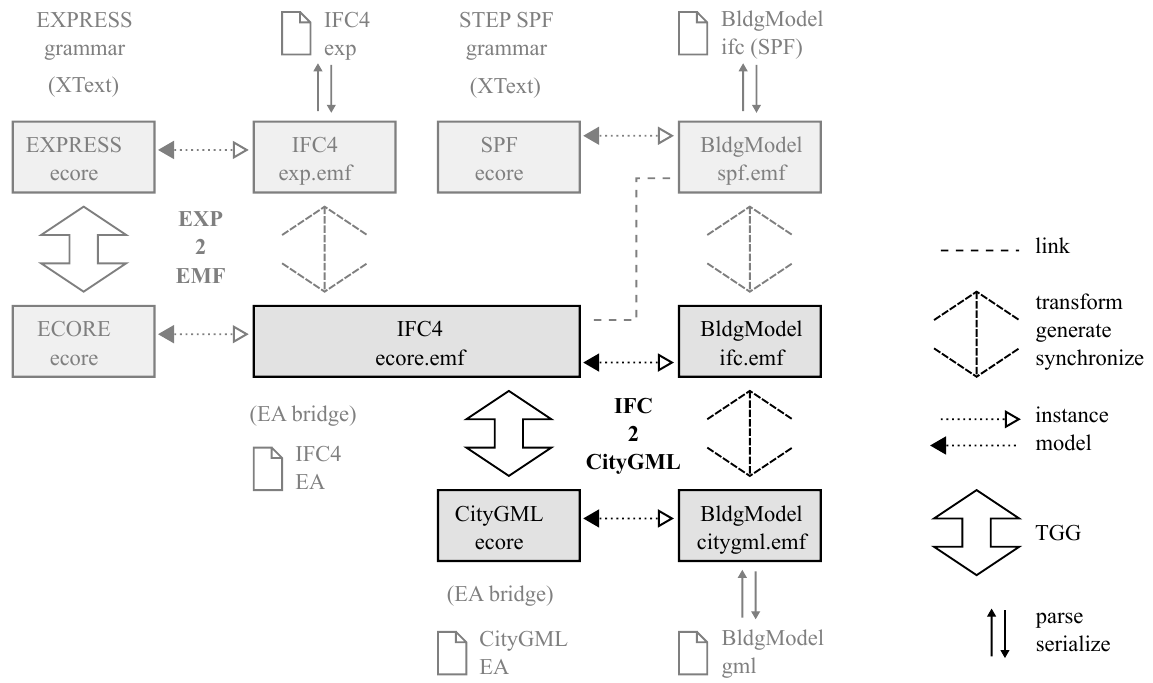
Figure 7. Work and data flow to integrate meta and instance models for IFC and CityGML